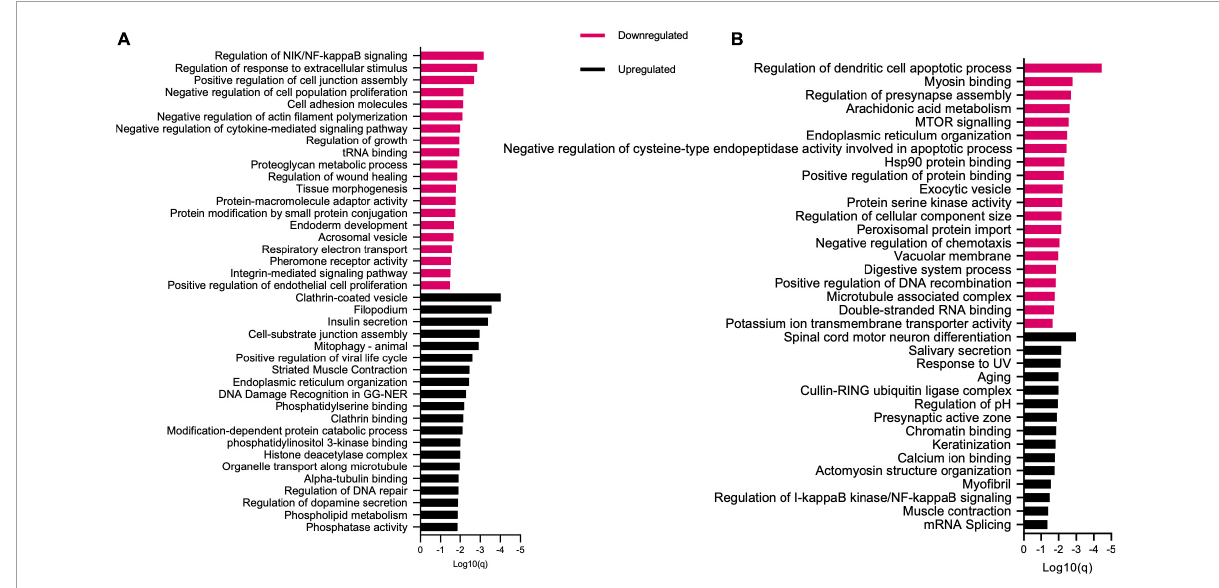
FIGURE4 Pathway enrichment analysis from up and downregulated differentially expressed genes in (A) BB group (diabetic rats treated with Anthocyanin-rich black beans extract). (B) DB group (diabetic rats without